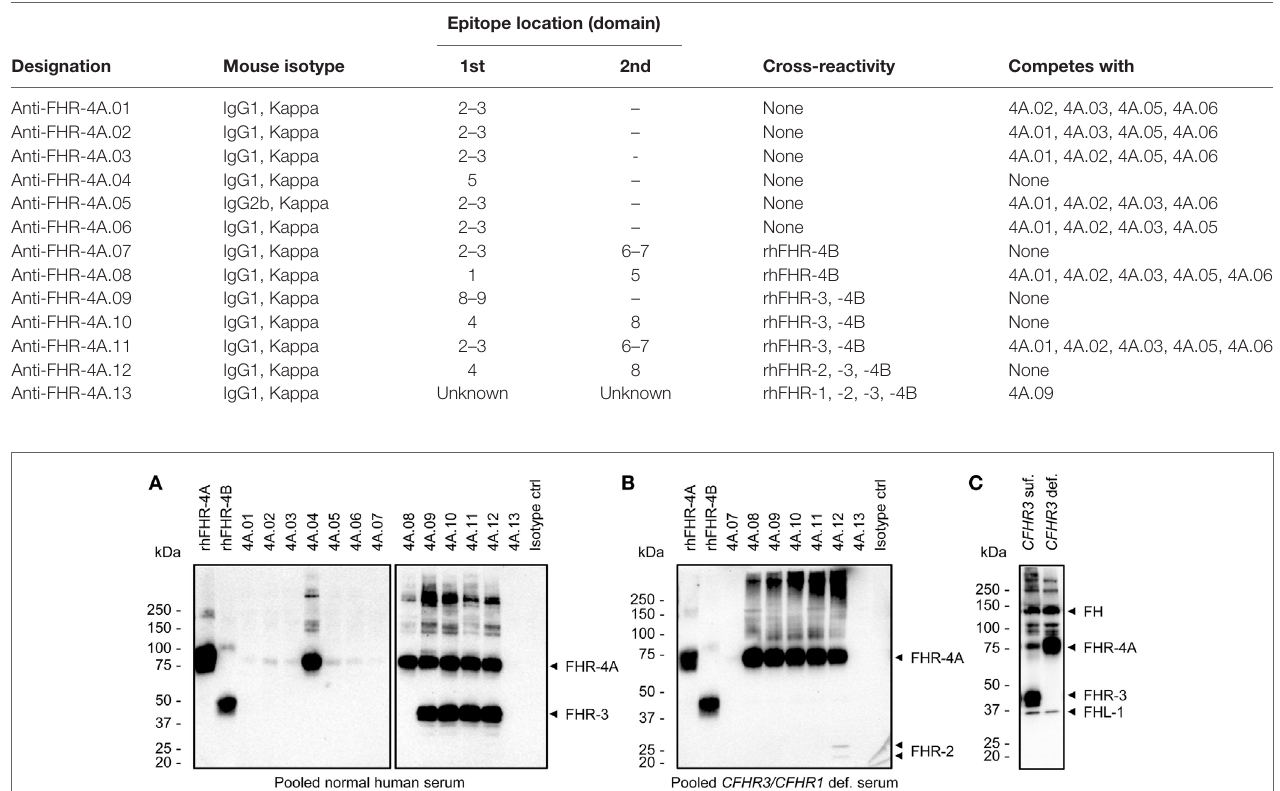
FigUre 2 | Immunoprecipitation (IP) of plasma-derived factor H-related (FHR) proteins by the anti-FHR-4A monoclonal antibodies (mAbs). (a) Western blot following IP from pooled normal human serum using the indicated mAbs. For comparison, 100 ng rhFHR-4A and rhFHR-4B were loaded on the left side of the gel. Precipitated proteins are indicated with arrowheads on the right side of the blot. (B) As in (a) , but with pooled serum of healthy donors who are deficient for CFHR3 and CFHR1 and using only the cross-reactive anti-FHR-4A mAbs for IP. (c) IP using polyclonal anti-FHR-3 and serum of two healthy donors with either two CFHR3 ( CFHR3 suf.) or no CFHR3 ( CFHR3 def.) gene copies. All Western blots were stained with cross-reactive biotinylated polyclonal anti-FHR-3. Precipitated proteins are indicated with arrowheads on the right side of each blot. Results are representative of multiple independent